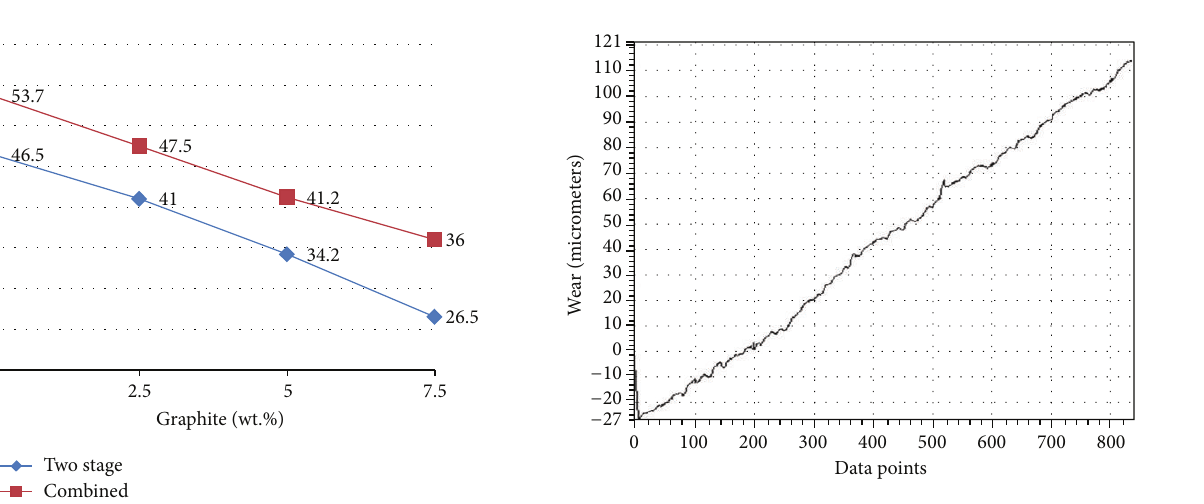
Figure 7: Typical curve of wear of Al-7.5 wt.% Gr composite against steel as a function of sliding time at 2m/s and applied load 49 N.